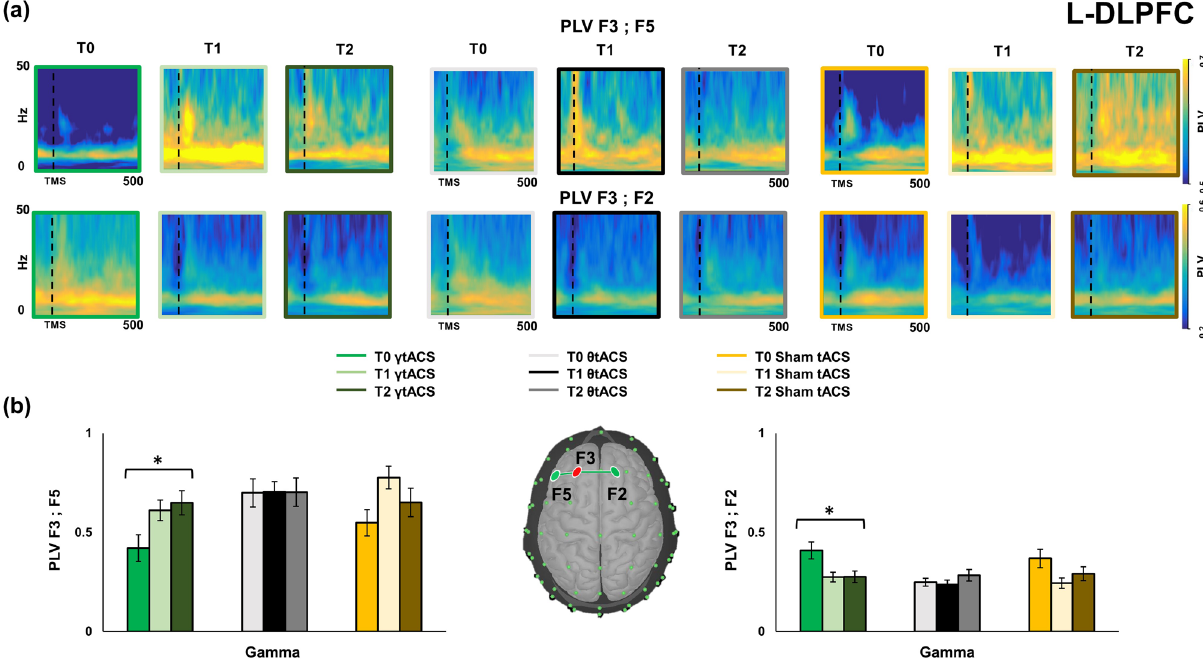
Figure 4. Paired electrodes Wavelet Phase-locking value (W-PLV) for the three stimulation conditions and time points on l-DLPFC. Panel ( a ) shows the W-PLV in a frequency (Hz) for time (ms) representation for each stimulation and time condition in both the paired electrodes considered for the analysis (F3 vs F5; F3 vs F2). All W-PLV time–frequency representations were generated by BrainVision Analyzer (v 2.2; https:// www. brain produ cts. com/ solut ions/ analy zer/). Panel ( b ) shows the histograms for the W-PLV in Gamma frequency for both the paired electrodes considered for the analysis. In the centre, a topographical representation of the electrodes is coupled for the